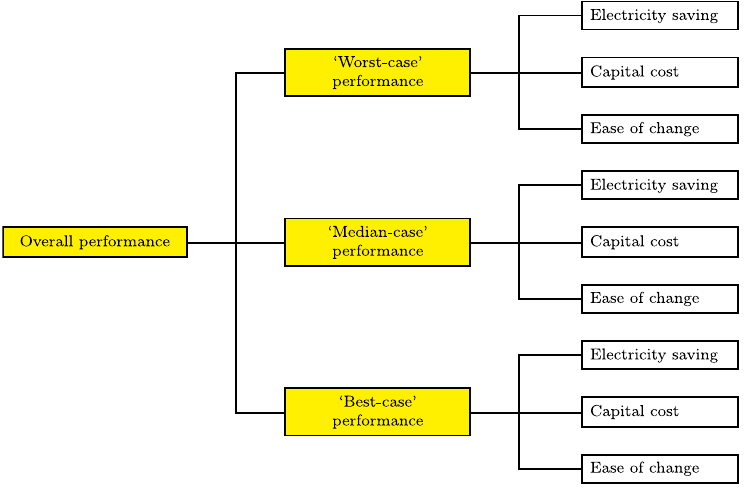
Figure 2: Value tree for selecting promising electricity savings options.